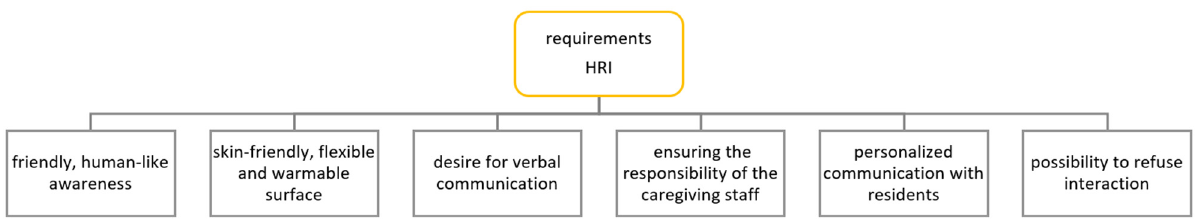
Figure 6. Overview of the identified HRI requirements.